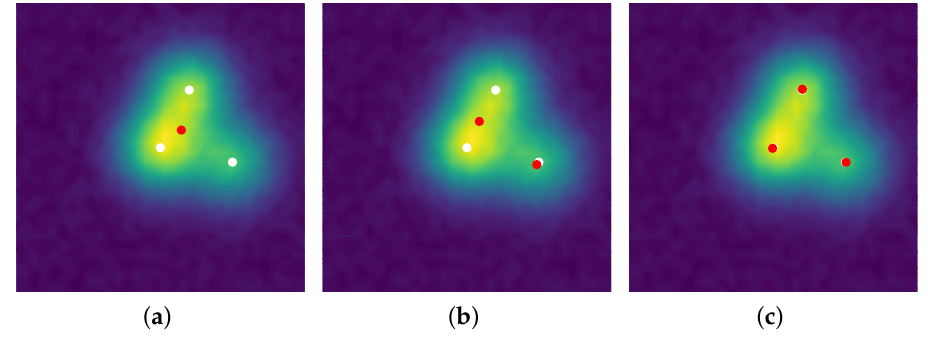
Figure 5. ( a ) First iterate k = 0; ( b ) mid-computation k = 1; ( c ) end of the computation k = 2, results for SFW reconstruction on the domain X = [ 0,1 ] 2 for the Gaussian kernel with spread-factor σ = 0.1 and additive Gaussian noise of variance 0.1. All δ -peaks are successfully recovered only thanks to the acquisition, λ = 3 × 10 − 2